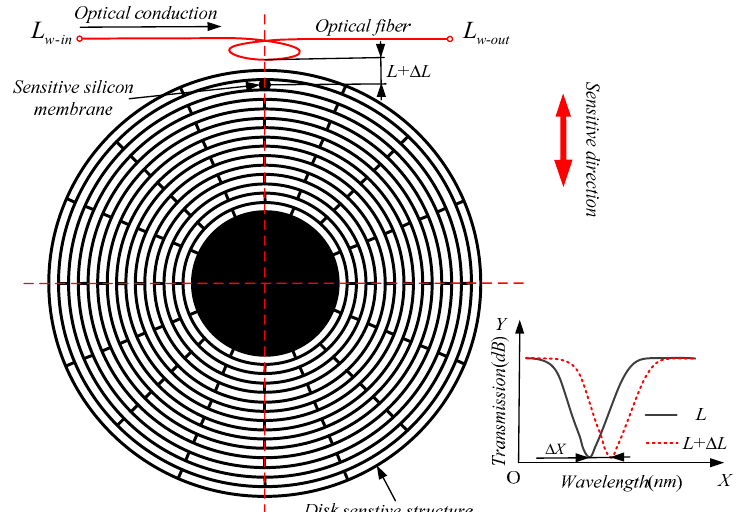
Figure 2. Working mechanism of the Micro Optoelectromechanical System resonator gyroscope (MOEMS-RG).